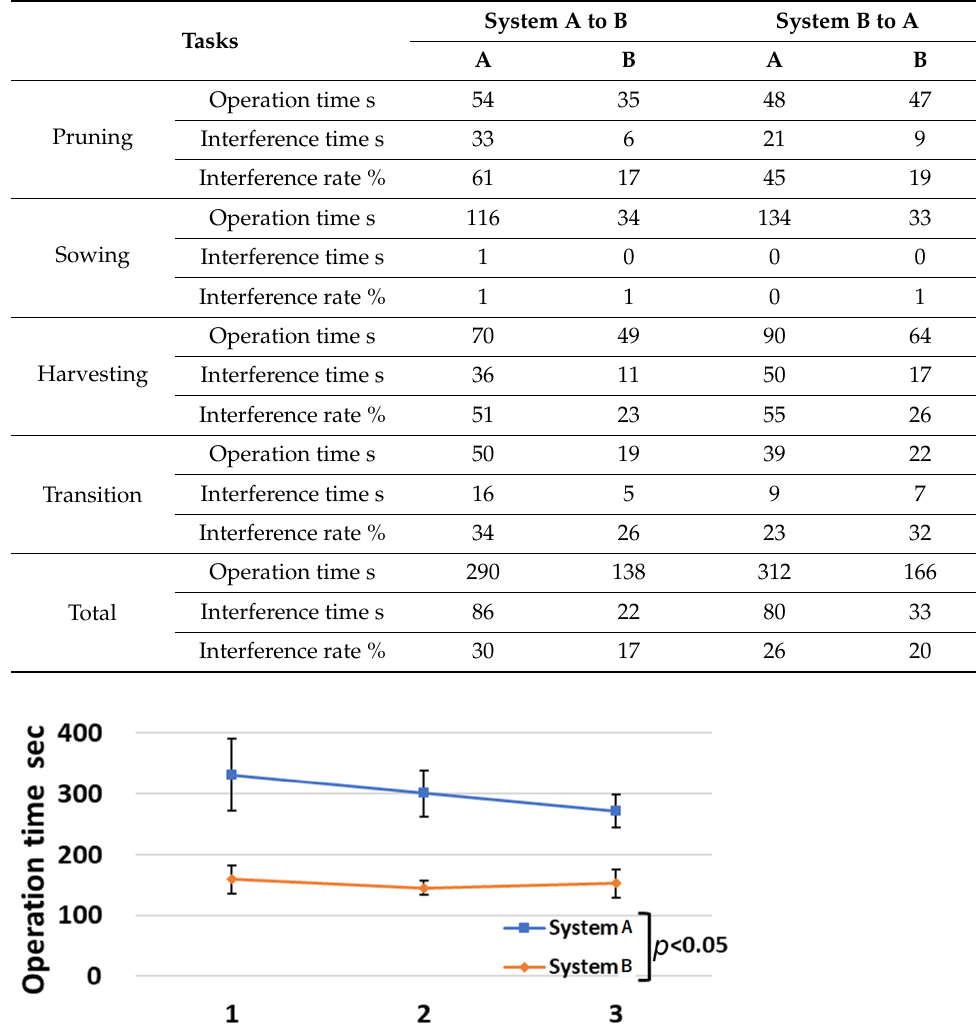
Table 4. Average operating time and interference rate with obstacles.